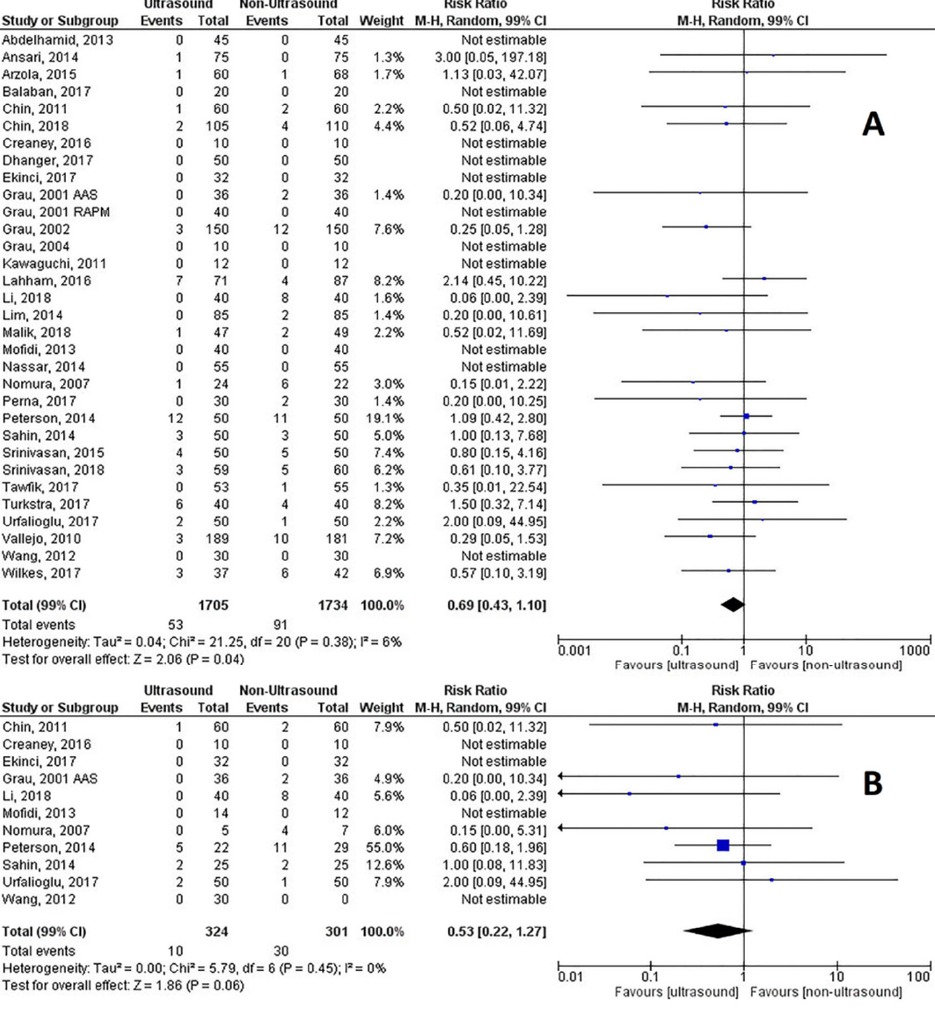
Figure 3. ( A ) Risk of technical failure of neuraxial procedures; ( B ) Risk of technical failure in difficult spines and obese patients.